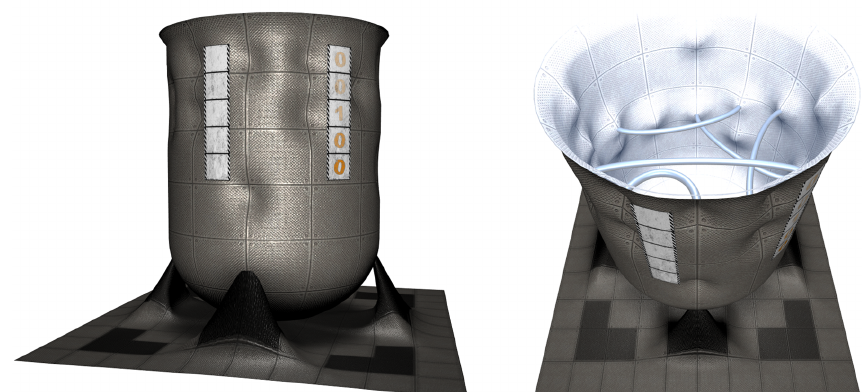
Figure 12. Snapshots of the Cohen-Sutherland’s thimble.